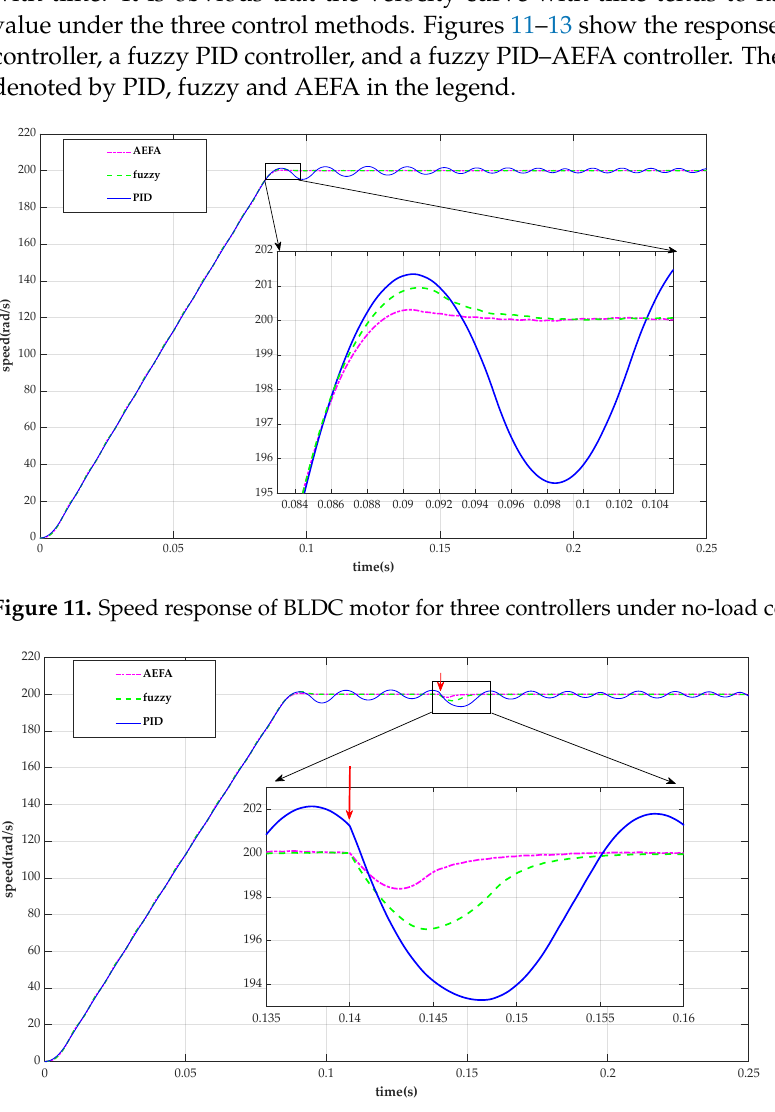
Figure 12. Speed response of BLDC motor for all controllers under the full-load condition.